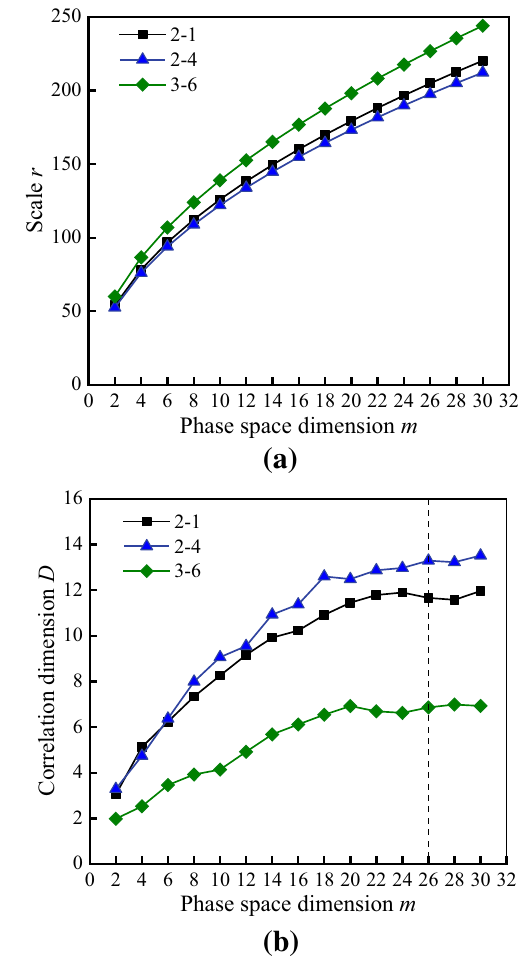
Fig. 7 The relationship between phase space dimension m and scale and the correlation dimension: a scale r , b phase space dimension